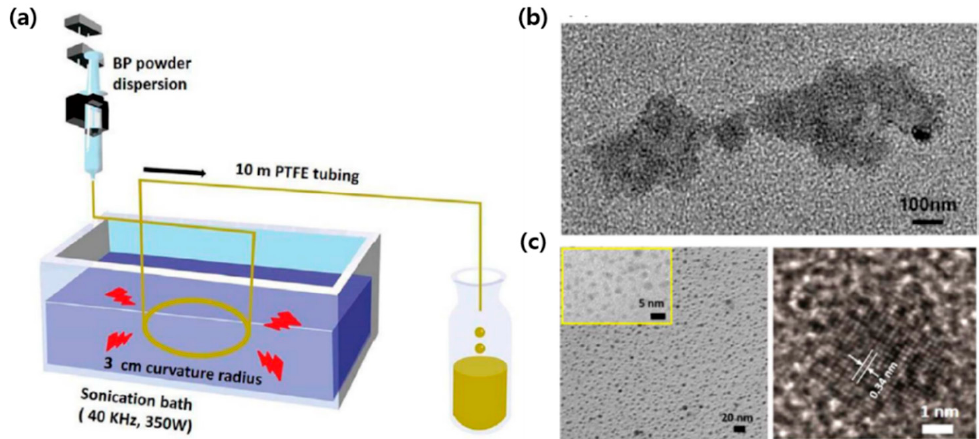
Figure 7. ( a ) Schematic of the acoustic–microfluidic (AM) exfoliation process, ( b ) TEM image of few-layer black phosphorus (BP) flake, and ( c ) TEM and HRTEM image of BPQDs. Reprinted with permission from reference [24], copyright 2018,